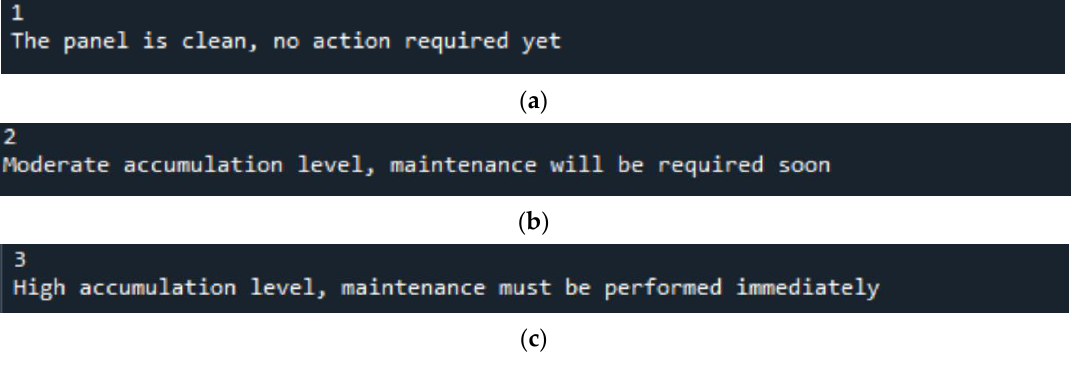
Figure 8. Message delivered by the system for ( a ) the CLN condition, ( b ) the MAL condition, and ( c ) the HAL condition.